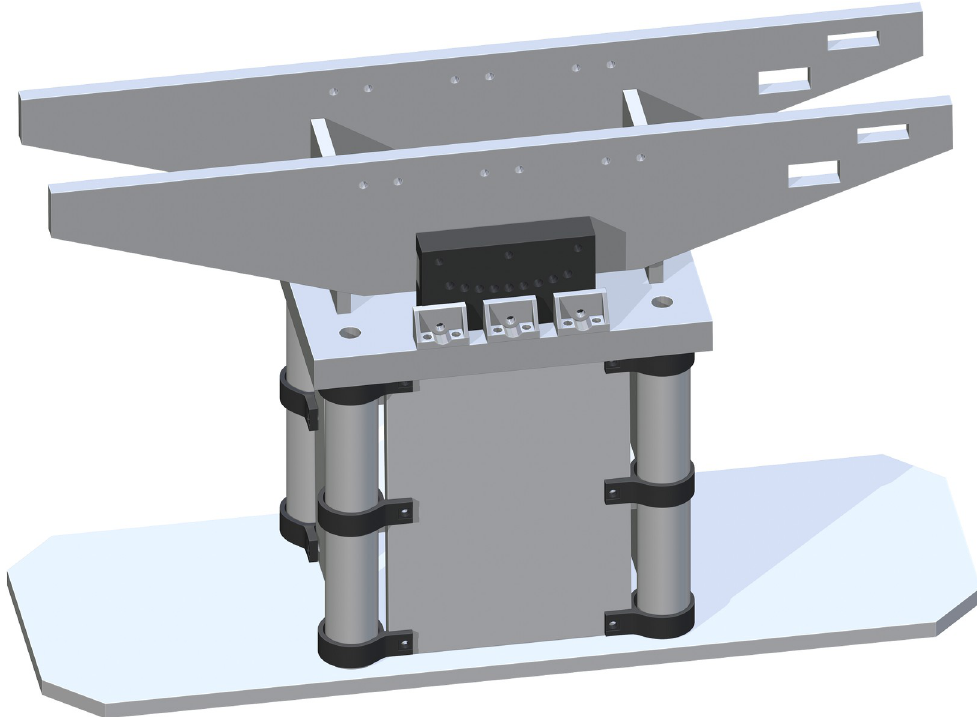
Fig 11. Final view of both Table Top Support